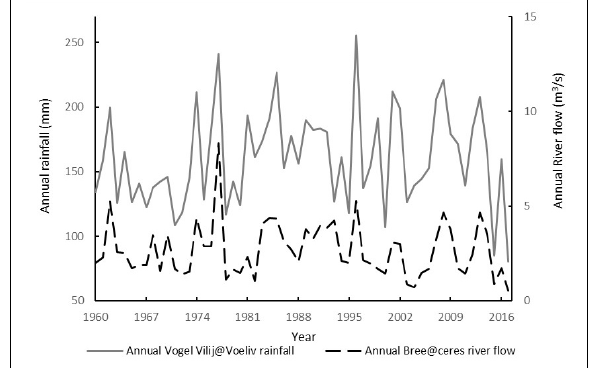
Annual Vogel Vilij@Voeliv rainfall and Bree@Ceres river flow over the period 1960–2017. The highest correlation coefficient (0.95) obtained is for Vogel Vilij@ Voeliv rainfall station and Little Berg@Nieuwkloof river flow station over the period 2007–2017, likely given their close proximity to each other. The relationship between rainfall at Vilij@Voeliv station with that for several river Pearson correlation coefficients ( r ) for annual rainfall and river flow over the periods 1960–2017, 1987–2017 and 2007–2017